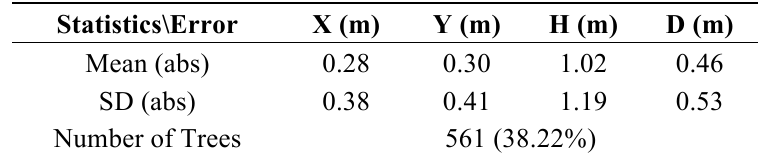
Table 3. Statistics of light detection and ranging (LiDAR) extracted tree features matched to those from the ground measured